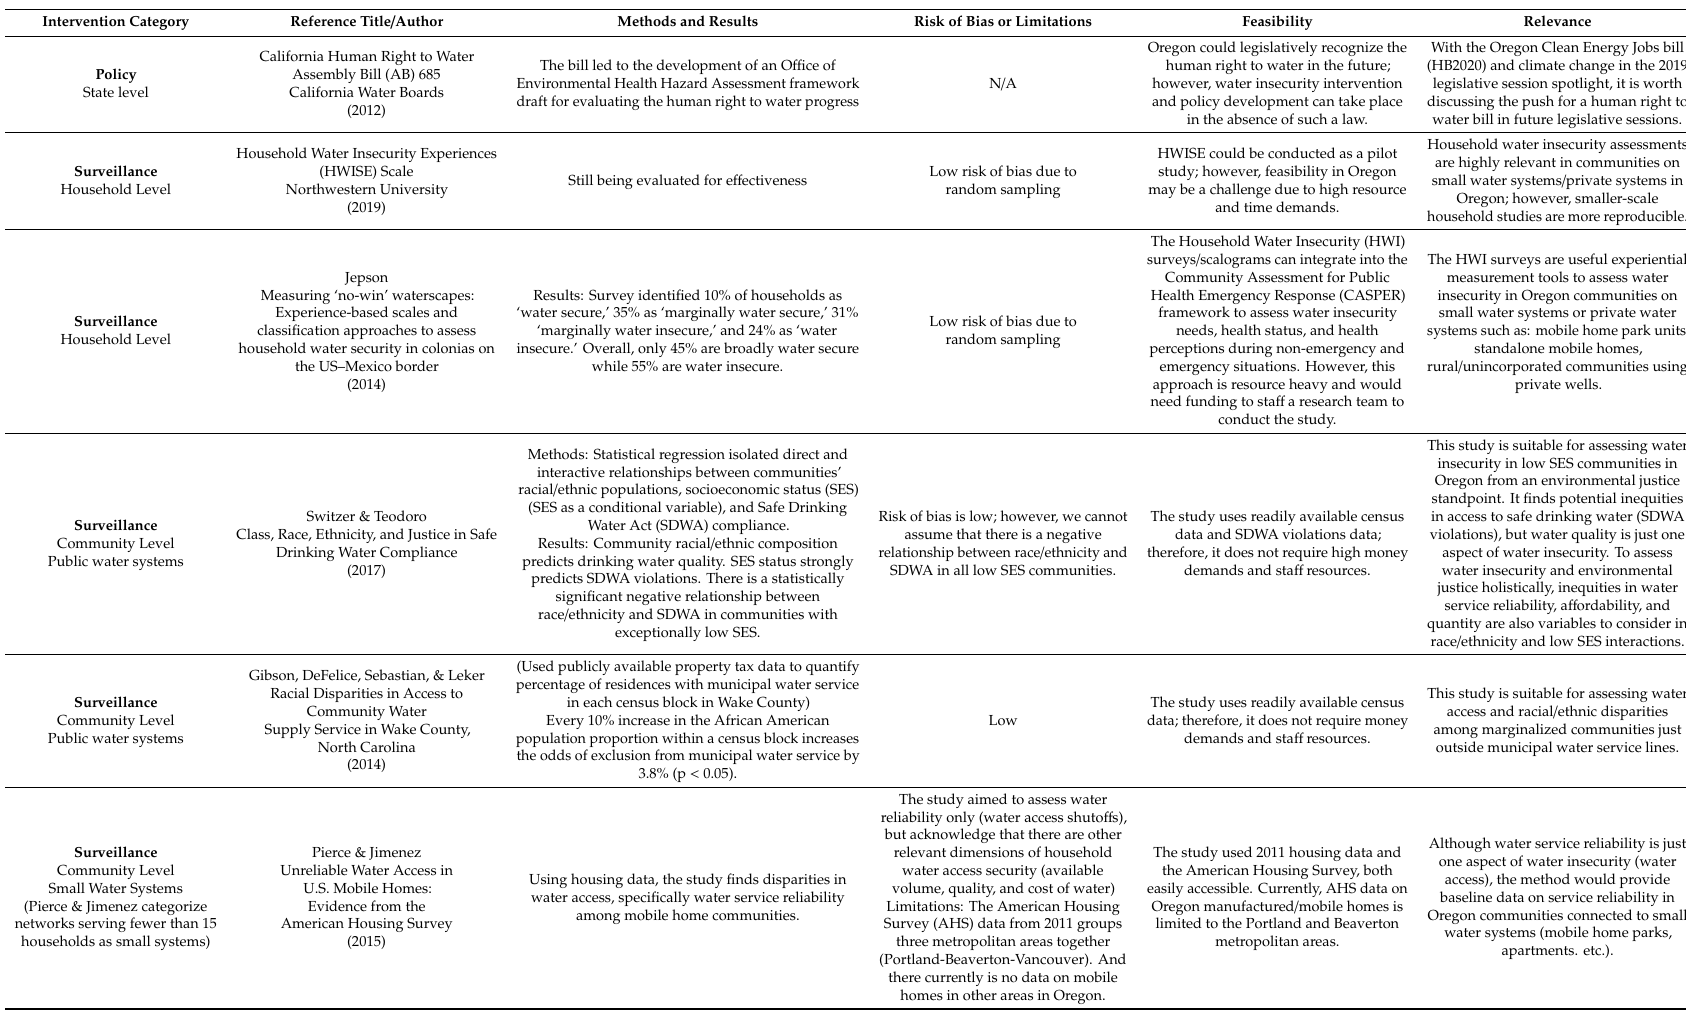
Table 3. Relevance and Feasibility of Interventions in